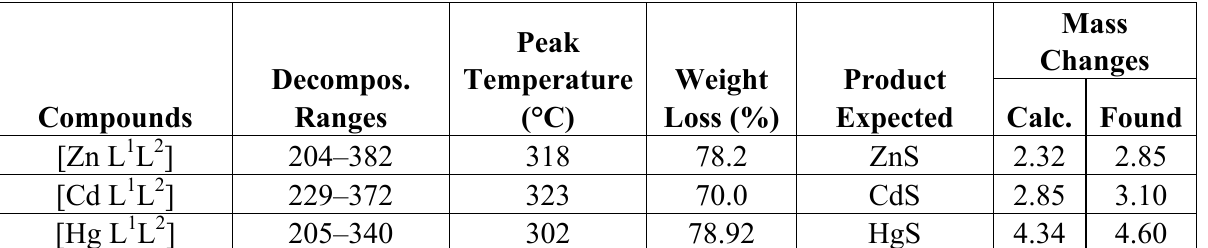
Table 1. Summary of the thermal characteristics for the N , N -ethyl phenyl N , N -butyl phenyl dithiocarbamate